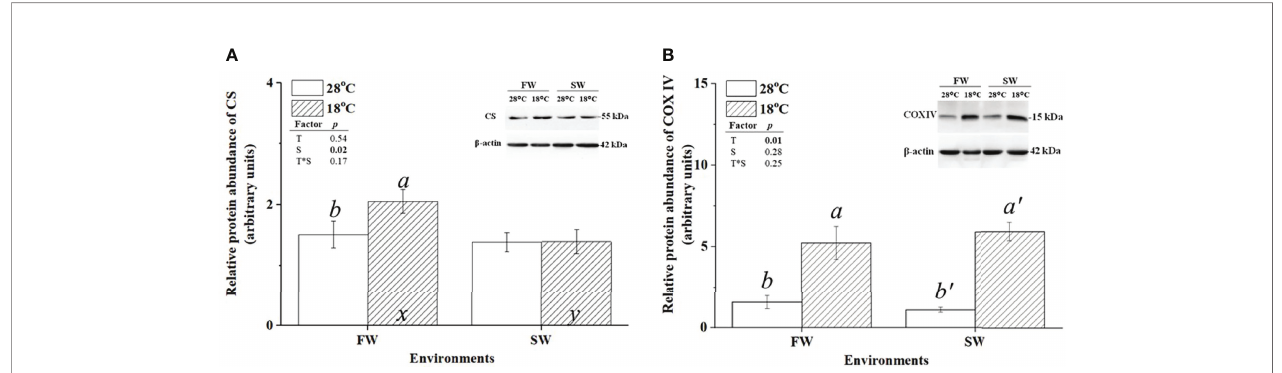
FIGURE 4 | Relative protein abundance of branchial citrate synthase (CS) and cytochrome c oxidase IV (COX IV) in freshwater (FW)- and seawater (SW)-acclimated milk fi sh at 28°C (white bar) and 18°C (striped bar). Representative immunoblots of CS (A) and COX IV (B) show a single immunoreactive band. The single immunoreactive band of b -actin at 42 kDa was used as the loading control. Different letters in the FW milk fi sh (a, b) and SW milk fi sh (a ’ , b ’ ) indicate signi fi cant differences between the normal and low-temperature groups. The x and y indicate signi fi cant differences between the FW and SW groups at 28°C or 18°C. Values represent the mean ± standard error of the mean (SEM), n = 9, P < 0.05.